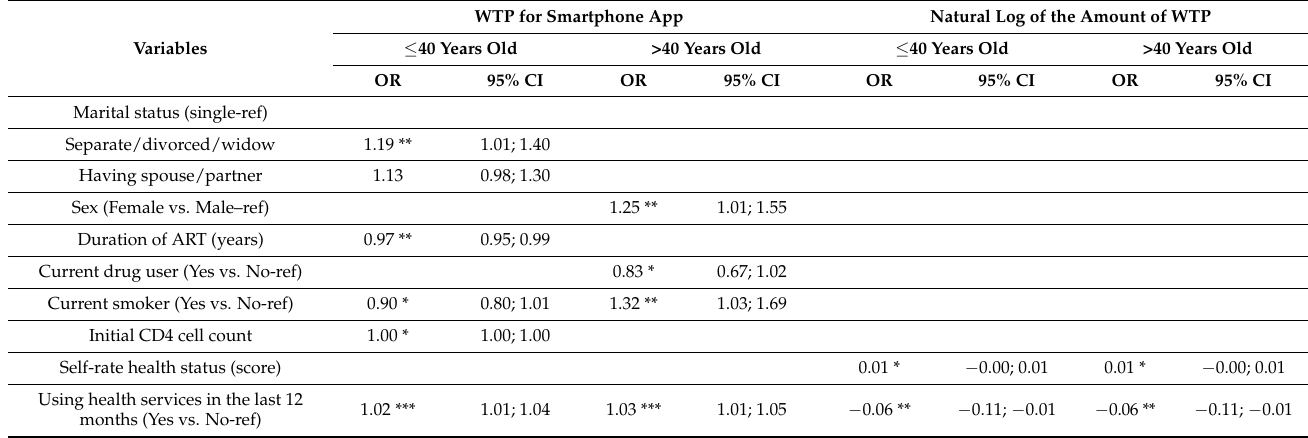
Table A3. Associated factors with WTP and the amount of WTP stratified by age